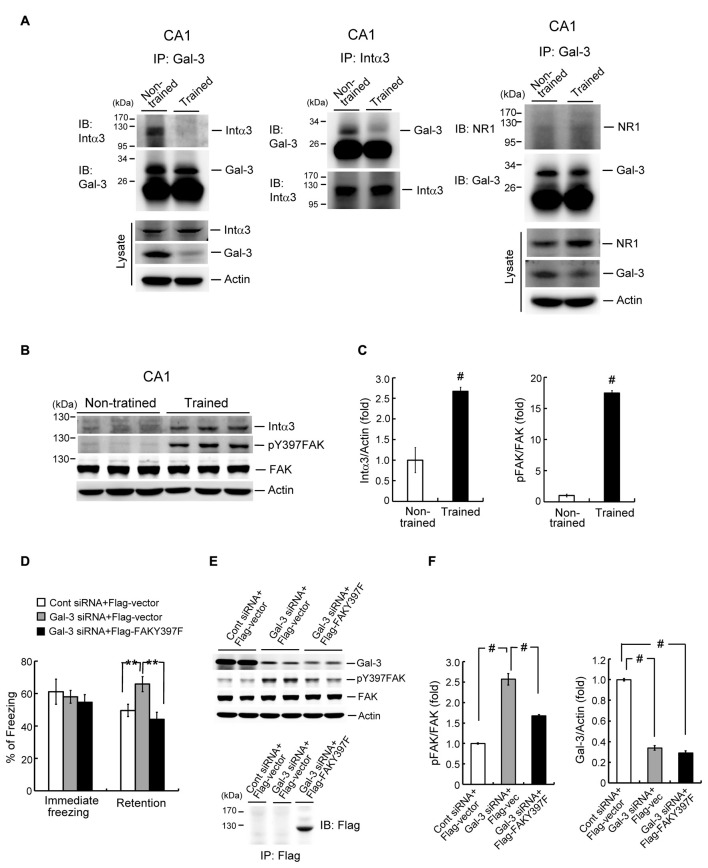
Galectin-3 negatively regulates fear memory through inhibition of integrin α3-mediated signaling. (A) Left and middle panel, Co-IP experiment showing galectin-3 association with integrin α3 and vice versa in rat CA1 area. This association is reduced after training (upper panels). Western blot showing the expression of integrin α3 and galectin-3 in trained and non-trained animals (lower-left panel). Right panel, Co-IP experiment showing that galectin-3 is not associated with NR1 in rat hippocampus, and fear-conditioning training does not apparently alter this relationship. Western blot showing that NR1 expression is increased, but galectin-3 expression is decreased in hippocampal cell lysate of trained animals (lower panel). Experiments are in two repeats. (B) Western blot showing the expression level of integrin α3 (t(1,10) = 5.18, P < 0.001), phospho-focal adhesion kinase (FAK; t(1,10) = 36, P < 0.001) and FAK in trained and non-trained animals. (C) Quantitative analysis of integrin α3 and phospho-FAK expression in trained and non-trained animals. N = 6 each group. (D) Immediate freezing response (F(2,24) = 0.33, P > 0.05) and retention performance in galectin-3 siRNA + Flag-vector and galectin-3 siRNA + Flag-FAKY397F co-transfected animals (F(2,24) = 7.0, P < 0.001; q = 3.81, P = 0.01 comparing the galectin-3 siRNA + Flag-vector group with control siRNA + Flag-vector group; q = 5.08, P < 0.01 comparing the galectin-3 siRNA + Flag-FAKY397F group with galectin-3 siRNA + Flag-vector group). N = 9 each group. (E) Western blot showing the expression level of galectin-3 (F(2,24) = 476.38, P < 0.001; q = 36.42 and q = 39.05, respectively; both P < 0.001), phospho-FAK (F(2,24) = 87.36, P < 0.001; q = 18.63, P < 0.001 comparing the galectin-3 siRNA + Flag-vector group with control siRNA + Flag-vector group; q = 10.63, P < 0.001 comparing the galectin-3 siRNA + Flag-FAKY397F group with galectin-3 siRNA + Flag-vector group) and FAK in galectin-3 siRNA + Flag-vector and galectin-3 siRNA + Flag-FAKY397F co-transfected animals. N = 9 each group. Immunoprecipitation and immunoblotting against Flag confirming the expression of FAKY397F in Flag-FAKY397F-transfected animals (lower panel). (F) Quantitative analysis of galectin-3, phospho-FAK and FAK expression in the same animals. N = 9 each group. Data are mean ± SEM. **P < 0.01, #P < 0.001.